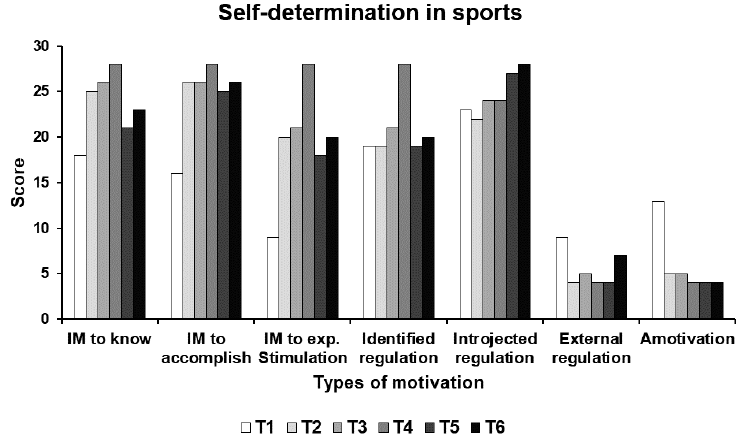
Figure 7. Results of self-determination in sports at the six test times (T1–T6). IM: intrinsic motivation; exp.: experience.